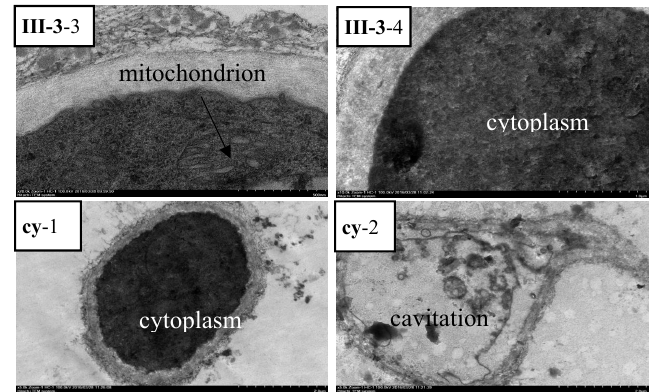
Figure 9. Effect of compound III-3 treatment on the ultrastructure of B. cinerea. CK-1: The blank control